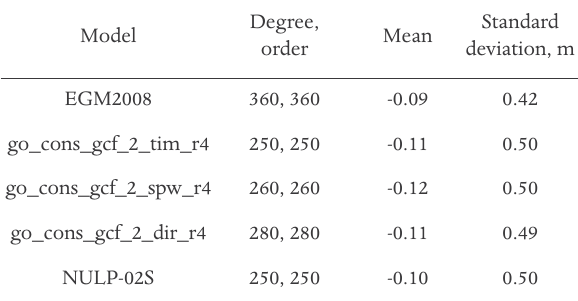
Table 1. Statistics of the differences between the measured GNSS/ levelling geoid heights and calculated from some gravity field mod- els data in the USA area (5379 GNSS/levelling